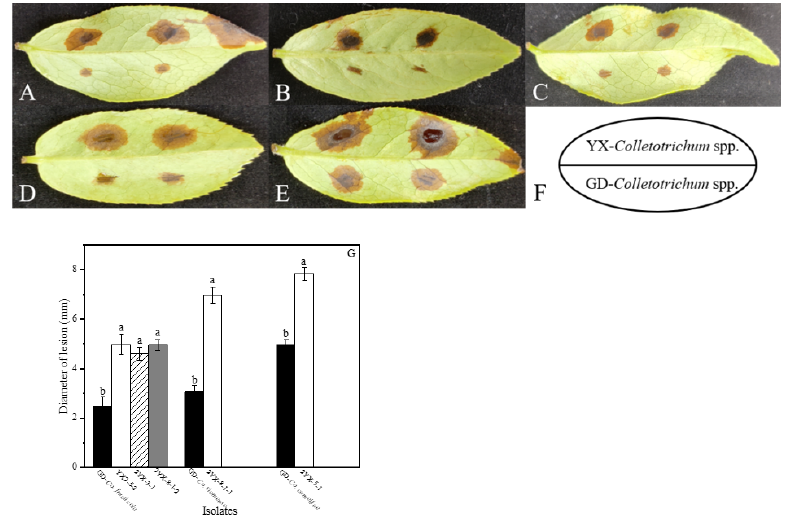
Figure 4. Pathogenicity of GD- Colletotrichum spp. (isolated from Camellia oleifera ) and YX- Colletotrichum spp. (isolated from Ca. yuhsienensis ) on Ca. yuhsienensis . ( A – C ) Lesion development by YX-Co. fructicola (YX2-5-2, 2YX-3-1, 2YX-8-1-2) and GD- Co . fructicola was photographed at 4 days post infiltration (dpi); ( D ) Lesion development by YX- Co . siamense (2YX-8-1-1) and GD- Co . siamense was photographed at 4 dpi; ( E ) Lesion development by YX- Co . camelliae (2YX-5-1) and GD- Co . camelliae was photographed at 4 dpi; ( F ) Schematic diagram of the pathogenicity test in which the conidia of GD- Colletotrichum spp. were infiltrated into the underside panel of the leaf, while those of YX- Colletotrichum spp. were infiltrated into the upper side panel of the same leaf; ( G ) Lesion diameters were measured at 4 dpi. The error bars represent standard deviations based on six biological replicates. Lesion diameters followed by the same lowercase letter are not significantly different at p < 0.05 using an